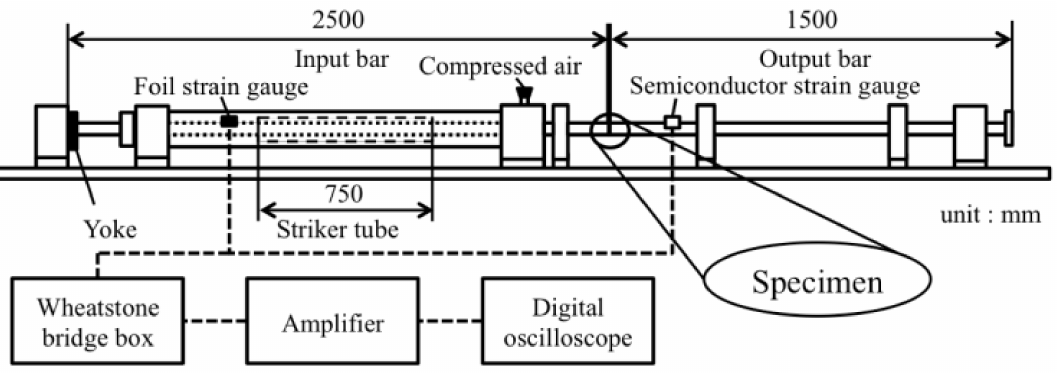
Figure 3. Configuration of the split Hopkinson pressure (SHB) apparatus [18].